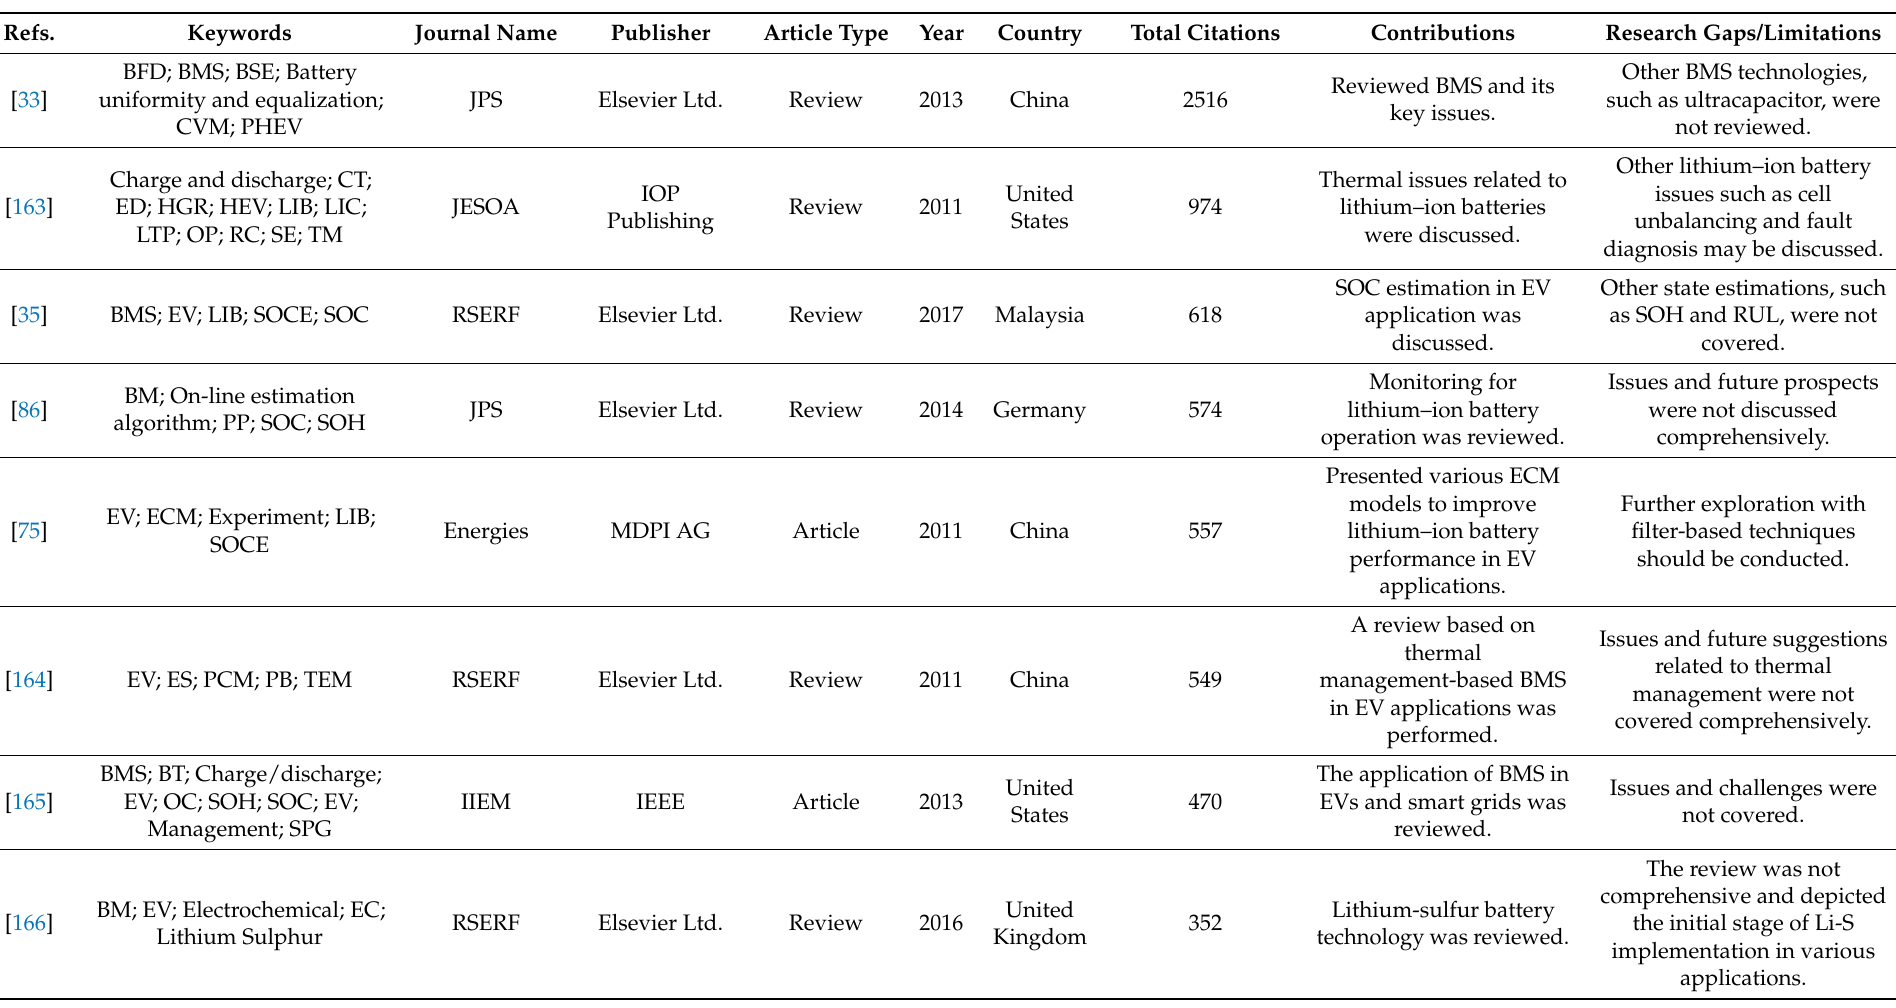
Table A1. 110 top-cited and highly influential manuscripts (2011–2020) in the area of battery management technology for EV applications.